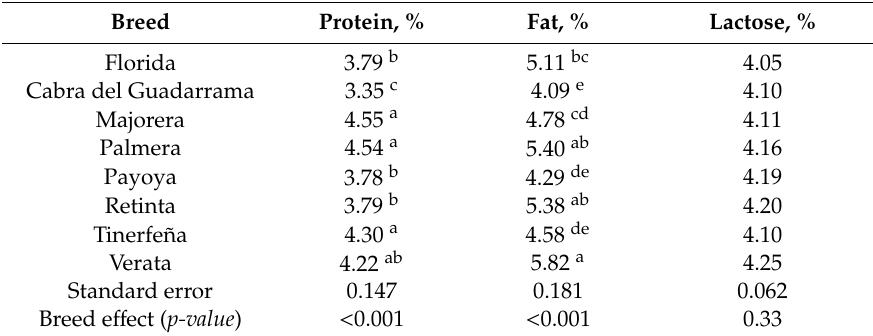
Table 1. Means, standard error and p -value for breed e ff ect on proximal composition of natural milk 30 d post birth in eight goat breeds. Breed Protein, % Fat, % Lactose, %